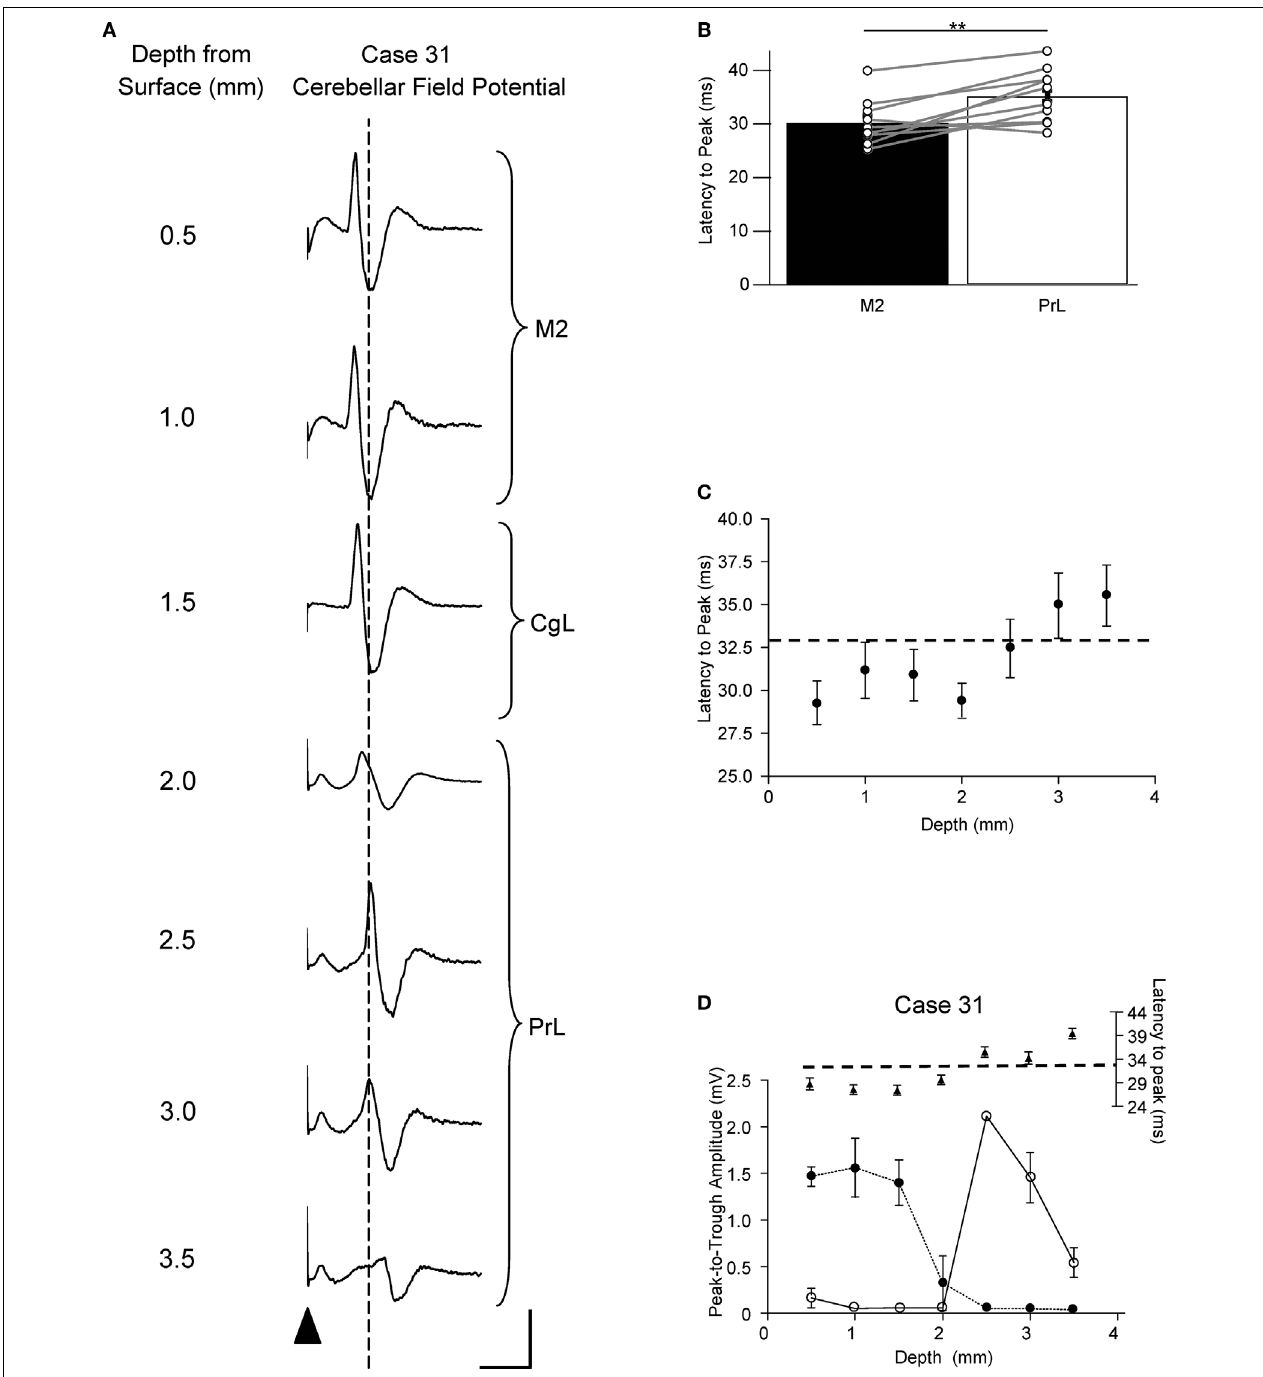
FIGURE 4 | Latency of lobule VII responses evoked by M2 and PrL stimulation. (A) Example case showing average fi eld waveforms ( n = 4), recorded on the surface of cerebellar vermal lobule VII, following frontal cortical stimulation (arrowhead) at various depths below the cerebral cortical surface. The dashed vertical line represents the latency to peak following PrL stimulation at a depth of 3 mm. (B) Pooled latency to peak of responses evoked by stimulation at 0.5–1 mm depth (M2) and 3–3.5 mm depth (PrL). Mean latency ± s.e.m. ** P < 0.005, Wilcoxon signed rank test, n = 10. (C) Average latency to peak of responses evoked by stimulation at varying dorso-ventral